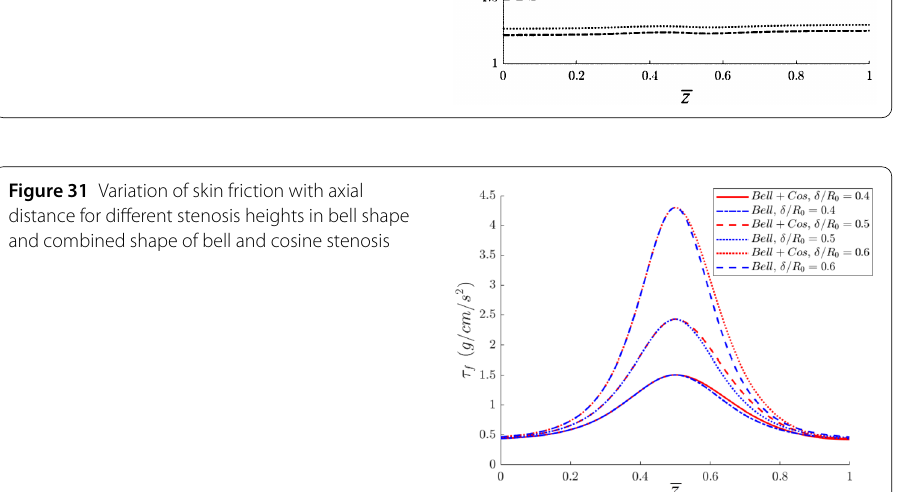
Figure 30 The resistance to the flow comparison between the bell shape with different m and cosine shape